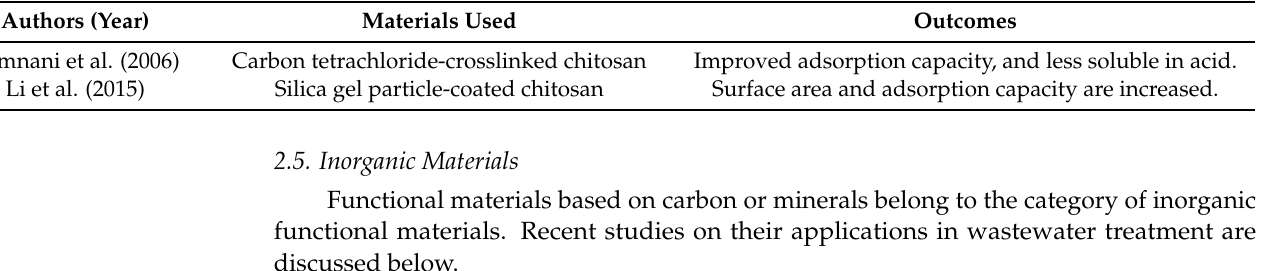
Table 4. Studies on chitosan-based functional materials for adsorptive application.